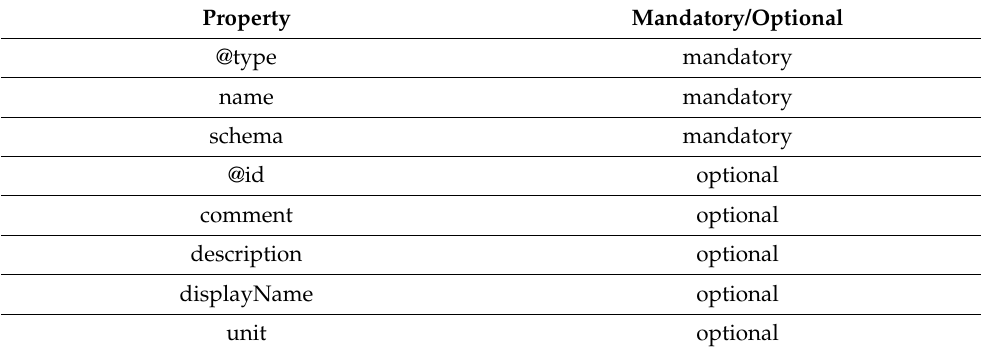
Table 5. Properties of the Telemetry class.